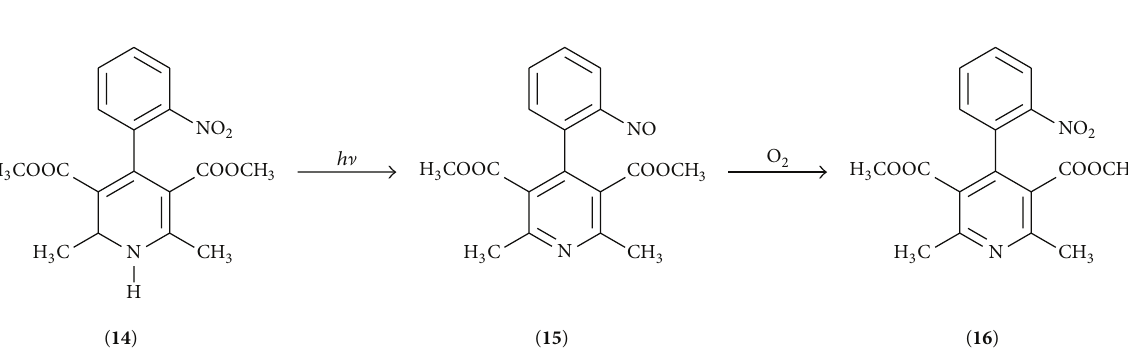
Figure 4: Photodehalogenation reaction of norfloxacin.